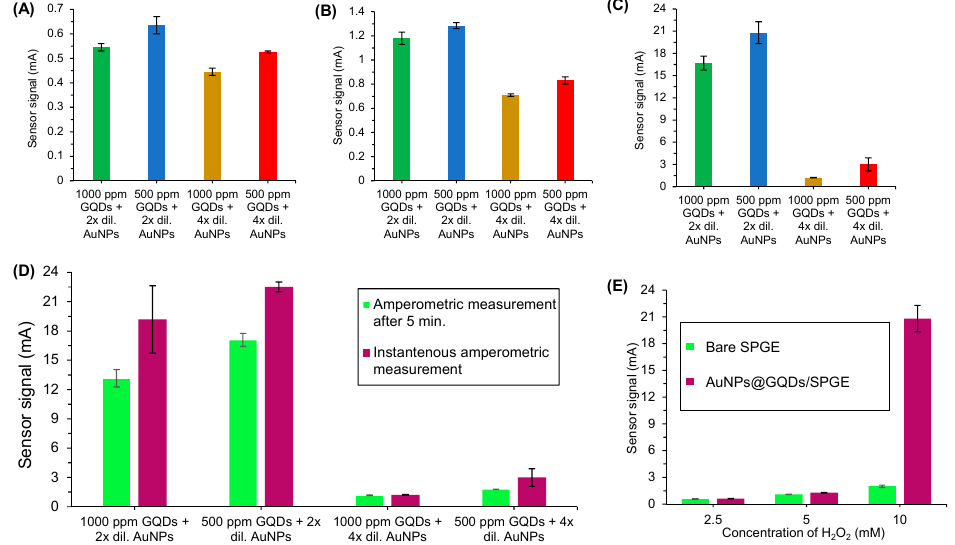
Figure 5. Signal–concentration relationship for various concentrations of nanocomposite mixture using ( A ) 2.5 mM H 2 O 2 ( B ) 5.0 mM H 2 O 2 ( C ) 10 mM H 2 O 2 , obtained by amperometric measurements. ( D ) Signal-nanocomposite relationship in amperometric measurements with and without waiting for 5 min after the application of 10 mM H 2 O 2 . ( E ) Comparison of the signal–concentration relationship between bare SPGE and AuNPs@GQDs/SPGE ( n = 3). 2 × and 4 × dilutions of AuNP solutions include 2.13 × 10 13 particles mL − 1 and 1.06 × 10 13 particles mL − 1 , respectively.